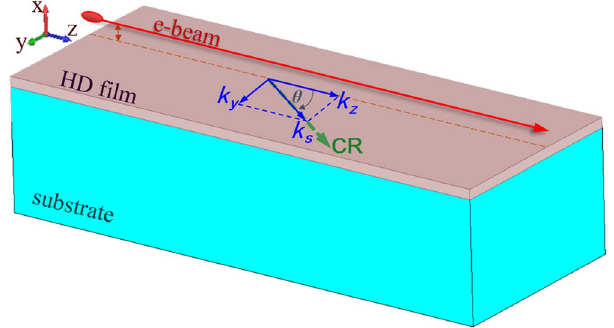
Figure 1. Schematic diagram of the free-electron exciting CR on a HD nano-film. The k s is the total horizontal wave-vector of the CR on the nano-film, k y and k z are respectively wave-vectors in the y-direction and z-direction. θ denotes the propagation direction of the CR on the nano-film.